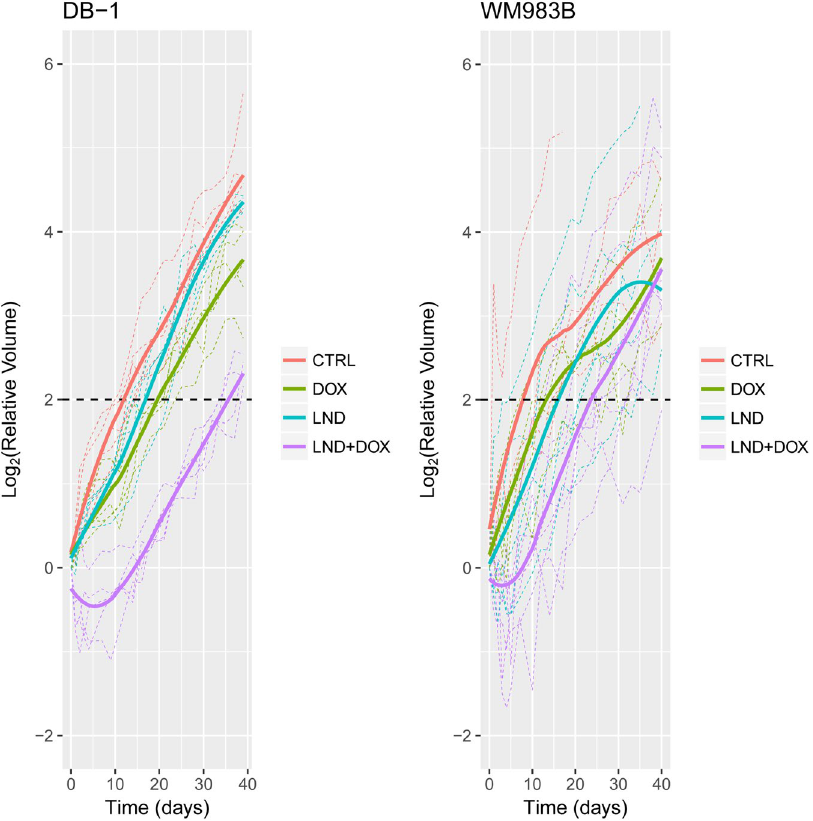
Figure 6. Lonidamine (LND) sensitizes both DB-1 and WM983B human melanoma xenografts to doxorubicin (DOX). On Day 0, nude mice with WM983B xenografts received treatment as follows: Control (sham i.p. tris/ glycine + sham i.v. PBS), LND (100 mg/kg i.p.), DOX (10 mg/kg i.v.), LND + DOX). The plots show the growth measurements for each animal relative to tumor volume at Day 0. Dark lines are the Loess-smoothed curves for each treatment group. The dashed line at 2 indicates 4 doublings. The data in the controls up to 12 days were used to determine doubling time. The data for DB-1 were re-analyzed from a previous publication in order to be comparable to the analysis for WM983B 14 .